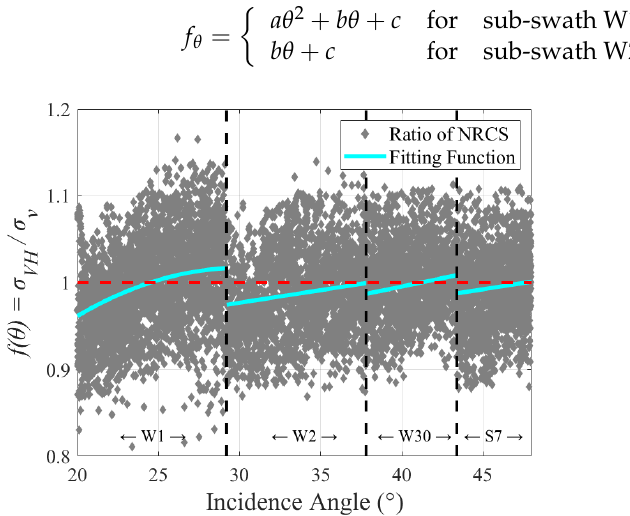
Figure 10. The values of the incidence angle correction function. The rhombuses denote the values evaluated by σ VH _ Actual / σ v . The light blue lines denote values calculated by the fitting function (5), the red dotted line represents the value of f θ = 1, and the three vertical black dotted lines represent the boundaries of the four sub-swaths. Table 3. List of the coefficients in Equation (5).